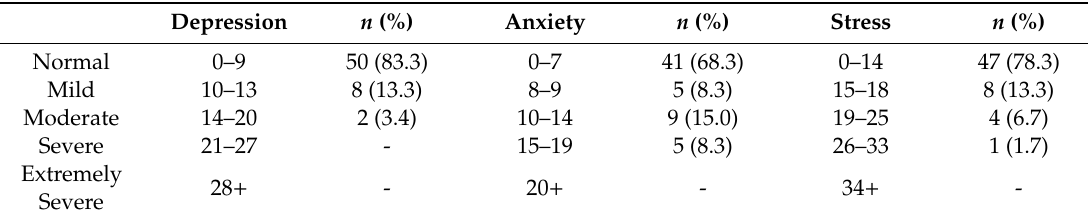
Table 2. Frequency of Depression, Anxiety, and Stress ( n = 60).